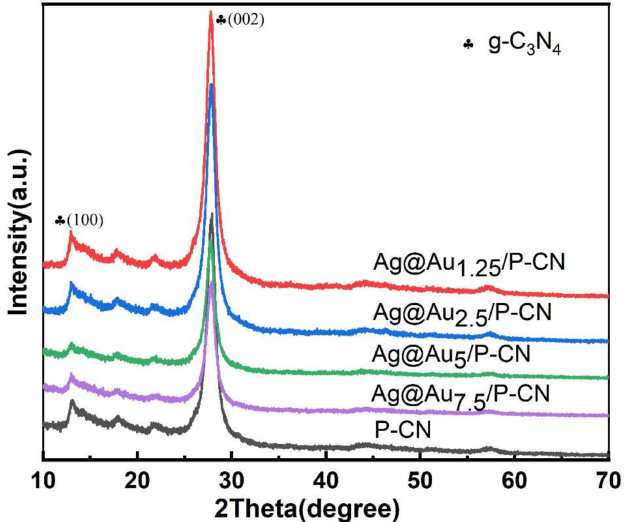
Figure 3. XRD of P-CN and Ag@Au 1.25 /P–CN, Ag@Au 2.5 /P–CN, Ag@Au 5 /P–CN, and Ag@Au 7.5 /P–